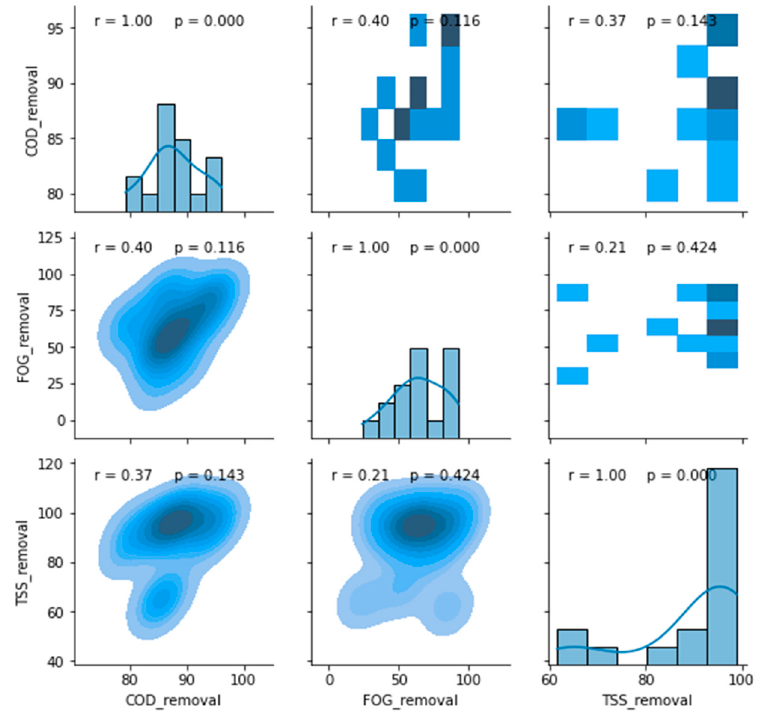
Figure 21. Correlation matrix between removal efficiencies of the MBR after DEGBR treatment.